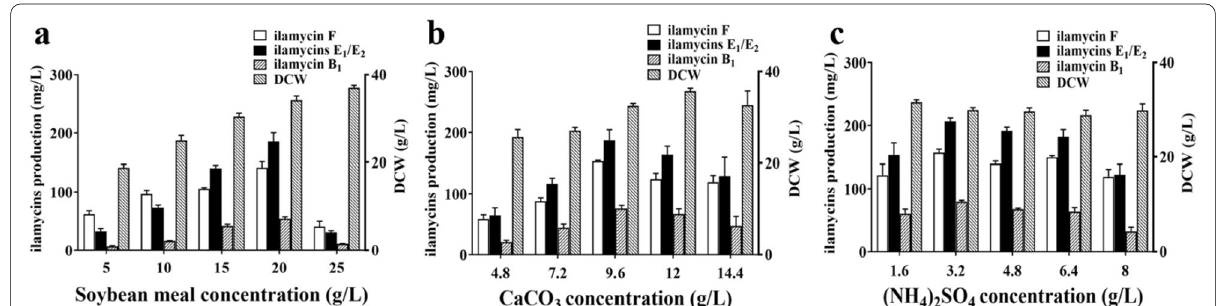
Fig. 3 Effect of soybean meal ( a ), CaCO 3 ( b ), and (NH 4 ) 2 SO 4 ( c ) concentrations on DCW and ilamycins